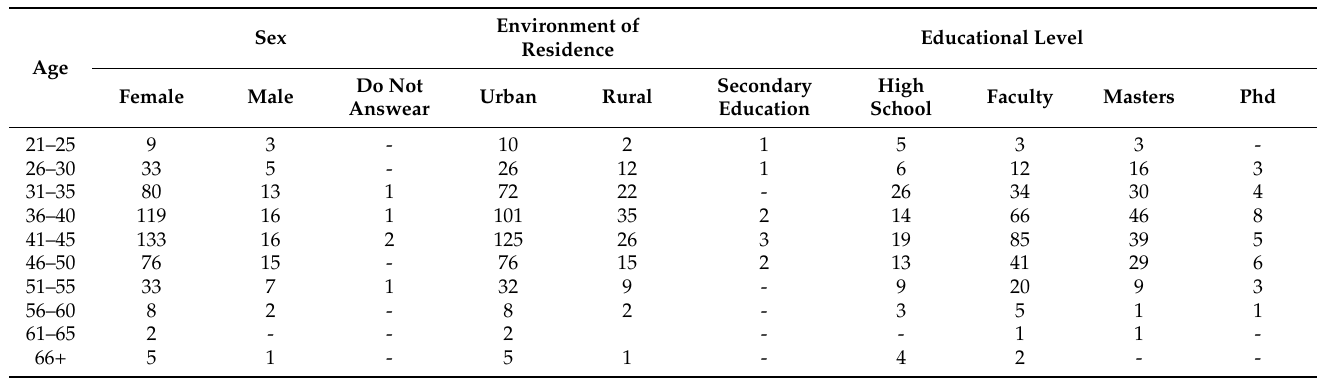
Table 2. Representation of socio-demographic data of